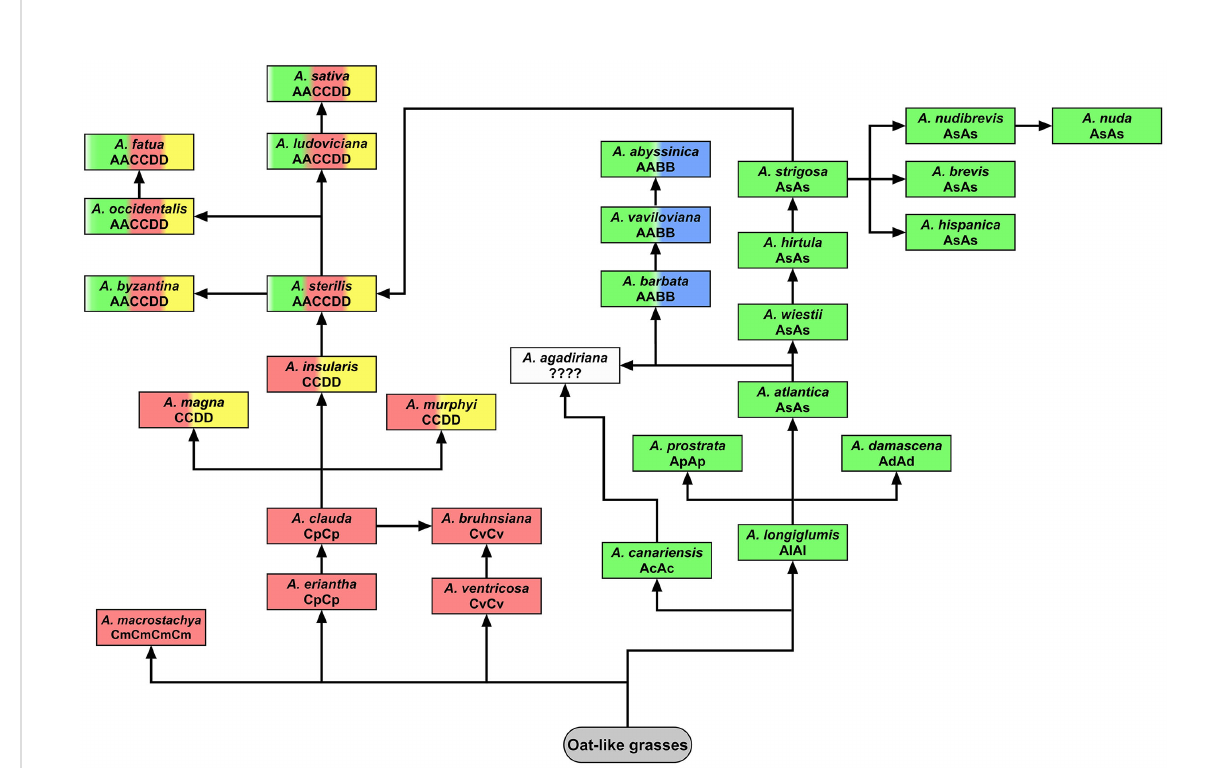
FIGURE 9 Model of potential evolutionary pathways leading to the development of modern tetraploid and hexaploid oat species based on the latest phylogenetic analyses. C and A genomes developed independently from oat-like grasses within the subgenus Avenastrum (Loskutov, 2007). According to Fu (2018), C-genome species diverged 19.9-21.2 million years ago (Mya), while A. canariensis , considered the oldest species having A genome, diverged 13-15 Mya. These data are contradictory to the analysis of chloroplast genome conducted by Liu et al. (2020), indicating that the diverged A genomes originate from A. longiglumis . A. bruhnsiana is an endemic species closely related to A. ventricosa , with A. clauda being a potential second ancestor (Gnutikov et al., 2022). Presumably different diploid species having the A and C genomes may have been involved in the evolution of polyploid oats (Peng et al., 2010). Species having AABB genomes ( A. barbata , A. vaviloviana , A. abyssinica ) show a close relationship with A. wiestii or A. hirtula . Peng et al. (2018) suggested that these species derived through autopolyploidization of A s genome, contrary to Badaeva et al. (2010) and Irigoyen et al. (2001) who proposed allotetraploid origin. According to Peng et al. (2018), A. agadiriana , which developed independently, is closely related to the A s and A c genomes, but the genome composition of this species remains debatable (this paper; Badaeva et al., 2010; Yan et al., 2016; Luo et al., 2018c). Phylogenetic analysis conducted by Peng et al. (2018) indicated that C p genome ( A. eriantha , A. clauda ) is more closely related to CCDD-tetraploids and AACCDD-hexaploids than C v genome ( A. ventricosa ). Probably not one, but several of the extant CCDD-tetraploids were involved in the formation of hexaploid oat species (Yan et al., 2021), but A. insularis and diploid species having A s genome seem to be putative ancestors of oat hexaploids (Drossou et al., 2004; Badaeva et al., 2005; Peng et al., 2018; Fominaya et al., 2021; Jiang et al., 2021). Molecular cytogenetic analysis revealed that none of the modern diploid oat species having A or C genome was the direct ancestor of polyploids, however, A. insularis showed a relatively high number of transcribed spacers, displaying sequence similarity to one accession of A. hirtula (Loskutov et al., 2021). On the other hand, the principal coordinates analysis revealed that A. eriantha and A. longiglumis are closer to CCDD oat tetraploids than other diploids (Yan et al., 2016). This was also proved by analysis of chloroplast and mitochondrial genomes (Fu, 2018), and easy crossing of A. longiglumis with CCDD tetraploids (see A. magna x A. longiglumis amphiploid in this paper; Drossou et al., 2004; Tomaszewska and Kosina,